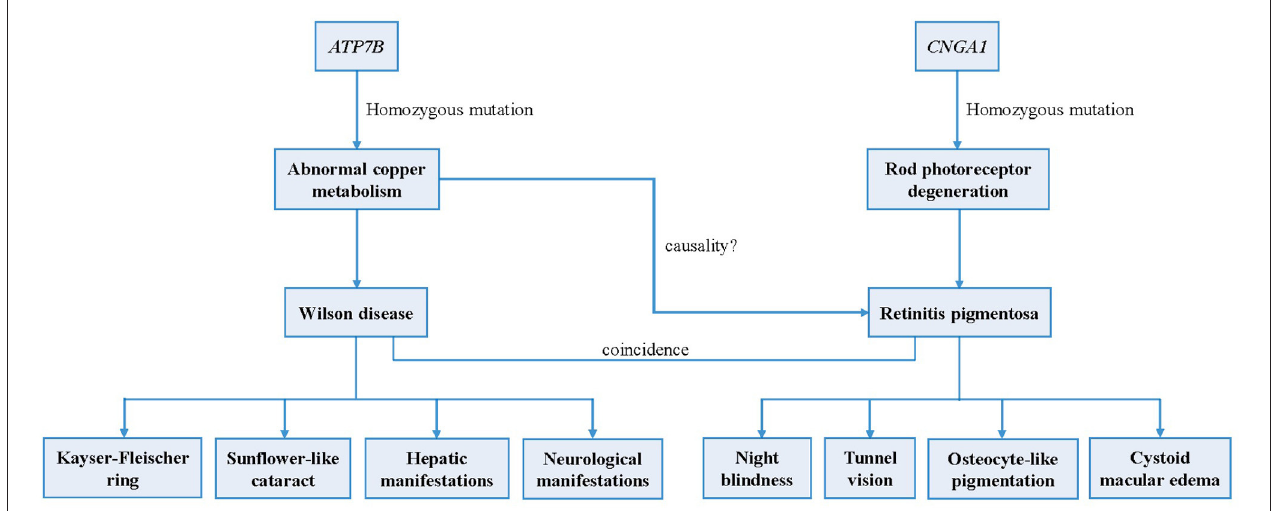
FIGURE 4 | Logical mapping illustrates the possible pathogenesis of Wilson disease and retinitis pigmentosa in this patient.